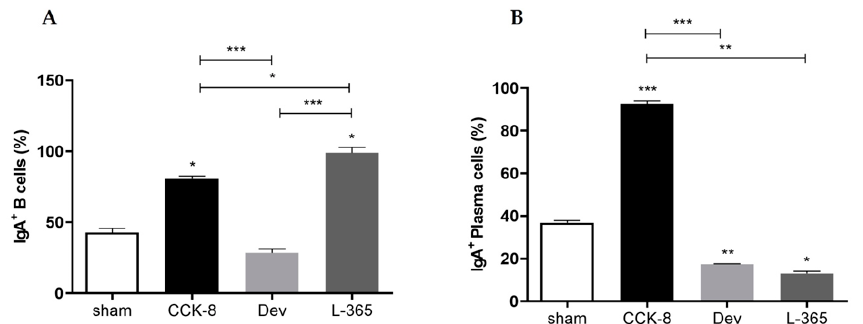
Figure 2. Percentage (%) of IgA + B lymphocytes ( A ) and IgA + plasma cells ( B ) in the lamina propria of the sham-, CCK8-, devazepide- and L365,260-treated groups. The results from one representative experiment (from three replicates) with eight mice per group are expressed as the mean and standard deviation (SD). * p < 0.05, ** p < 0.01 *** p < 0.001 and upon column comparisons vs. control group or upon line comparisons among the CCK8, devazepide and L365,260 groups.